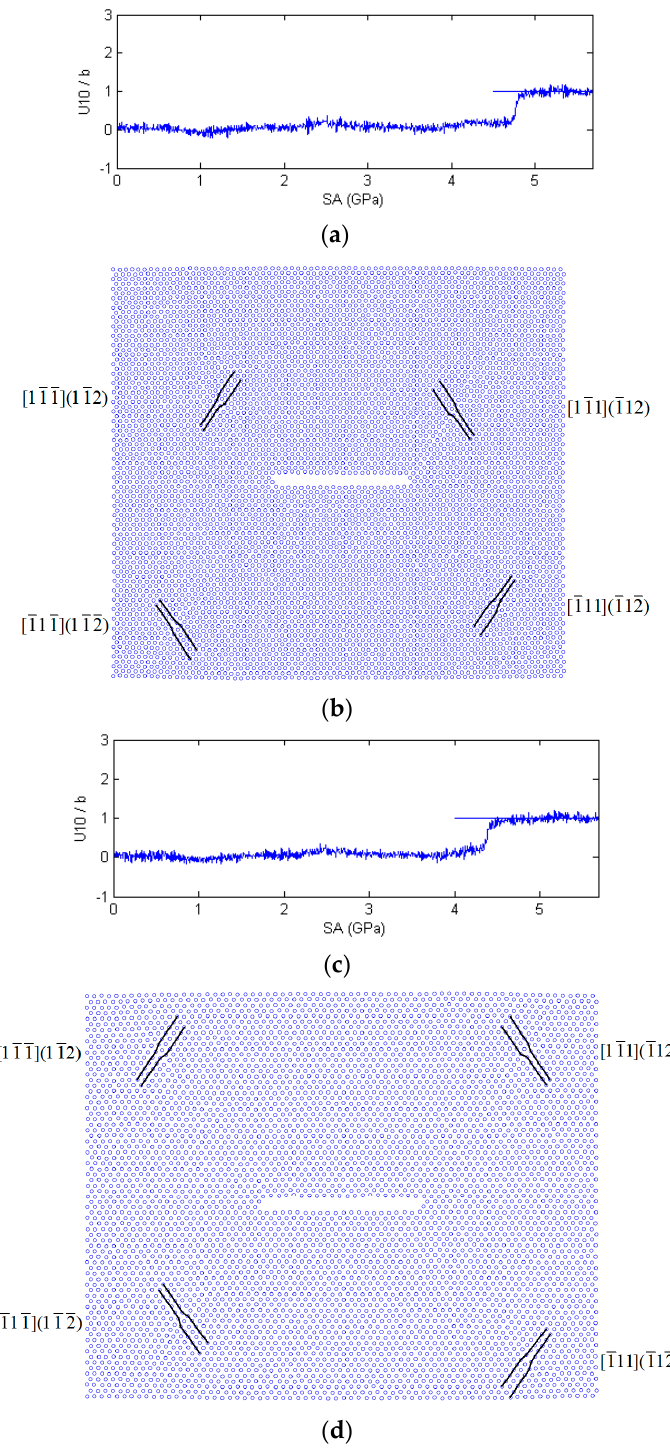
Figure 9. Temperature 600 K—comparison of MD results obtained with the stable time step h = 1 × 10 − 14 s and the smaller time step h 2 = 1 × 10 − 15 s for α = 0.0: ( a ) the shear displacements U10/ b in the slip systems <111>{112} in dependence on σ A ( t ) = SA, using time step h ; ( b ) 2D visualization of the emitted dislocations in middle layer 14 of the crystal at time step h = 5200 ( ∆ t = 4200 h , K A (t) = 0.484 MPa·m 1/2 ); ( c ) development of shear displacements U10 / b with increasing σ A ( t ), using the smaller time step h 2 ; ( d ) 2D visualization of the emitted dislocations under equivalent loading at time step h 2 = 52,000 ( ∆ t = 42,000 h 2 , K A (t) = 0.484 MPa·m 1/2 ). Similar to 300 K, the number of the emitted dislocations decreases with increasing biaxiality ratio α also at 600 K. The last emission of only two blunting dislocations <111>{112} at the